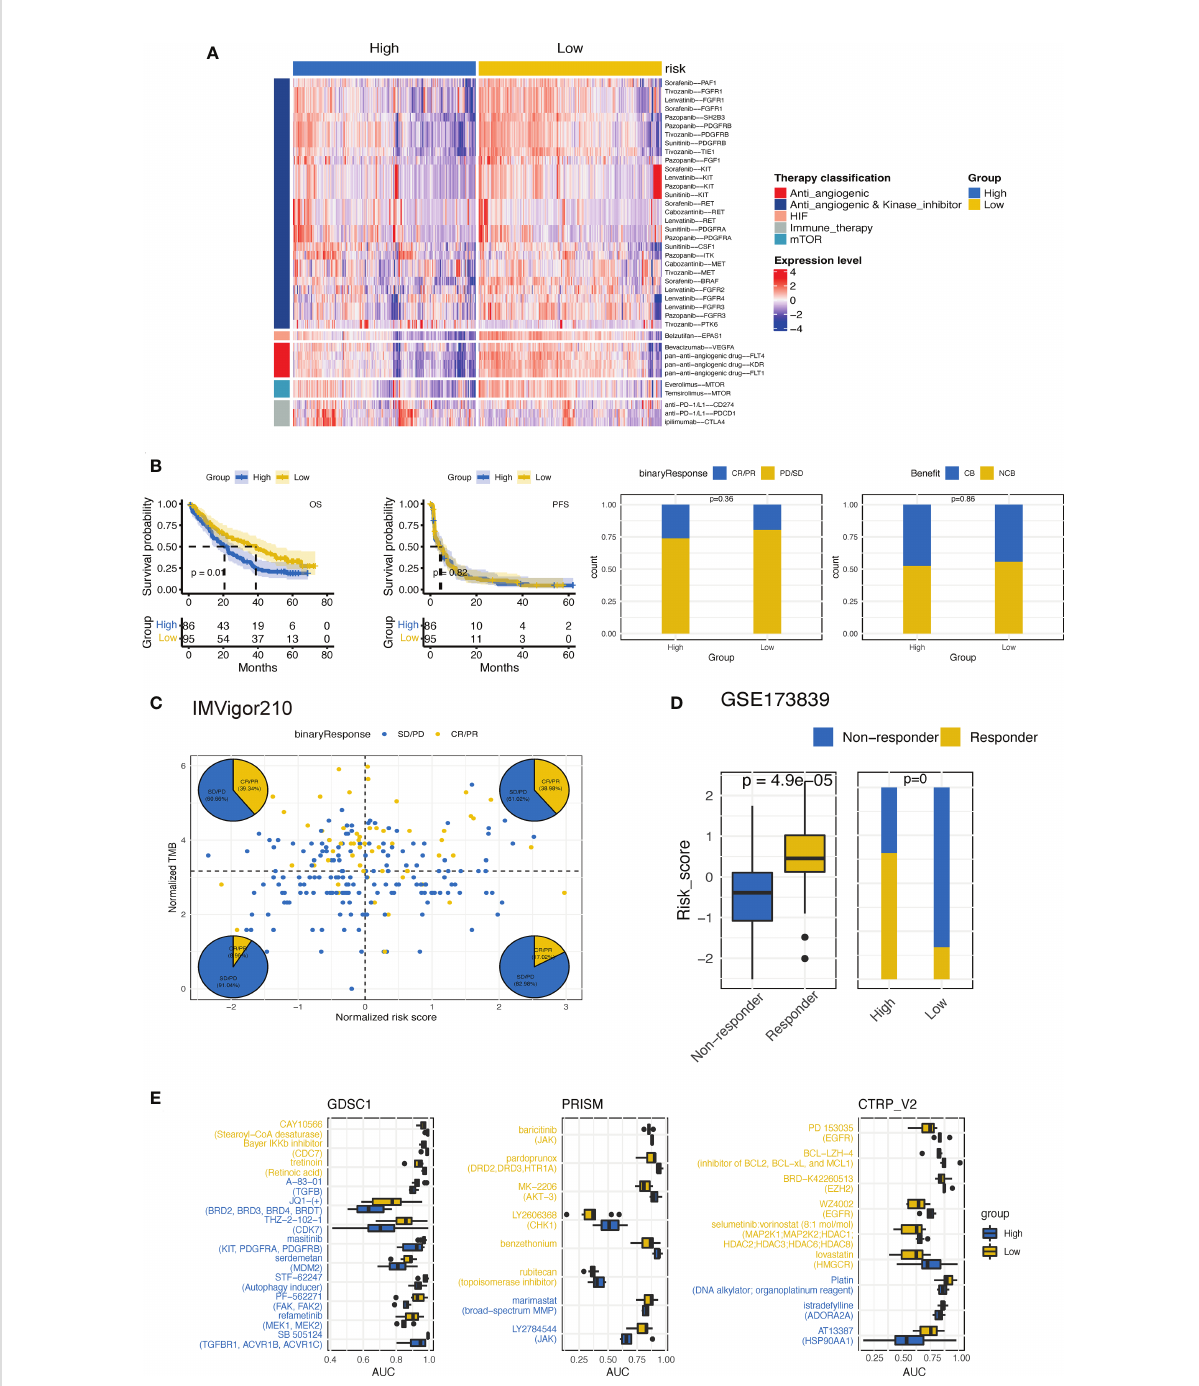
FIGURE 11 Estimation of treatment response correlated with CTR score. (A) Heatmap of the expression of ccRCC-related drug-target genes screened from the Drugbank database in high and low claudin-TME related (CTR) groups. (B) Kaplan – Meier curves and the difference in response rate between high and low CTR scores in nivolumab-treated ccRCC patients from CheckMate-009, 010 and 025 cohorts. (C) Response analysis with tumor mutational burden (TMB) and CTR score strati fi cation in IMvigor210 cohort. (D) Comparison of the CTR score between responders and nonresponders and the response rate between high and low CTR score groups from the GSE173839 cohort. (E) Three drug sensitivity databases (CTRP-V2, PRISM, and GDSC1) were used to identify the sensitivity of high and low CTR group cell line subsets to speci fi c agents. Agents with lower area under the curve (AUC) values on the x-axis of boxplots had a greater drug sensitivity, and those colored with blue had a higher sensitivity in the high CTR